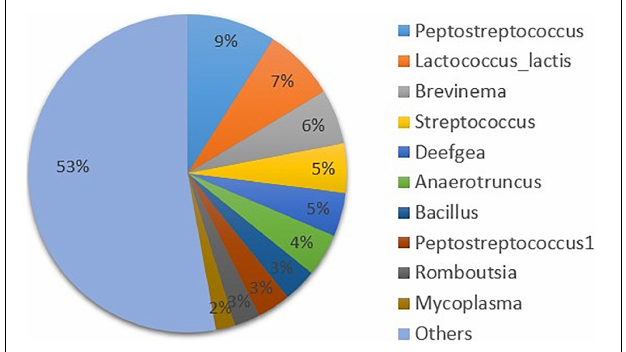
FIGURE 3 | Mean relative abundance of the top 10 bacterial operational taxonomic units (OTUs) in the gut microbiota of rainbow trout from 0 to 30 days on the commercial and experimental diets ( n =